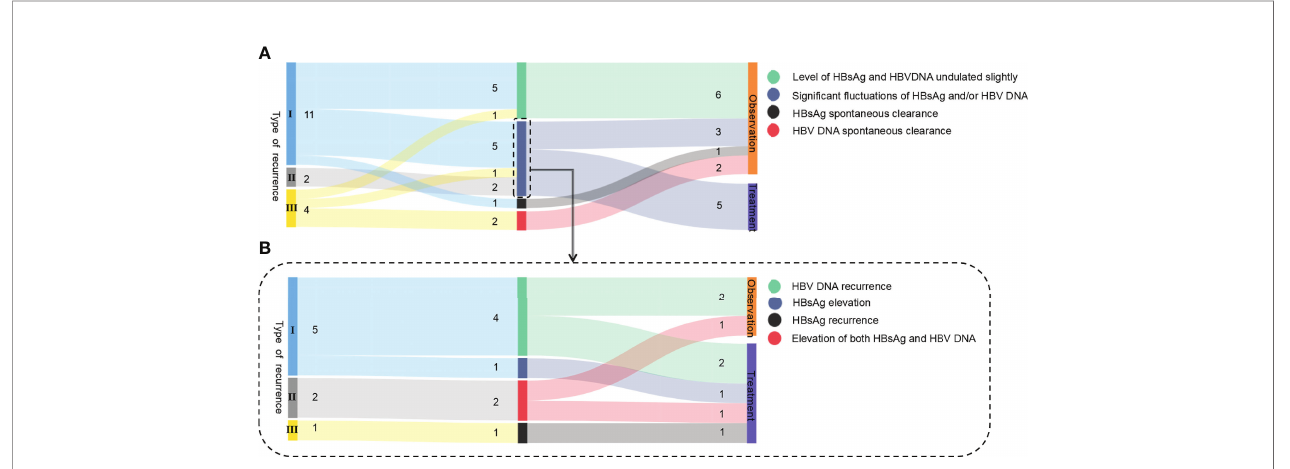
FIGURE 1 | Sankey diagram of the 8 cases of recurrence. (A) Follow-up retreatment of 17 relapsed patients selected for dynamic observation initially. (B) Follow-up retreatment of 8 relapsed patients with hepatitis B serological changes. I, II, and III in the fi gure represent the type of recurrence, and the Arabic numerals represent the number of